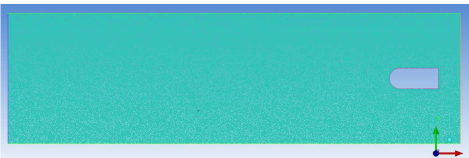
Figure 3. Grid independence verification.